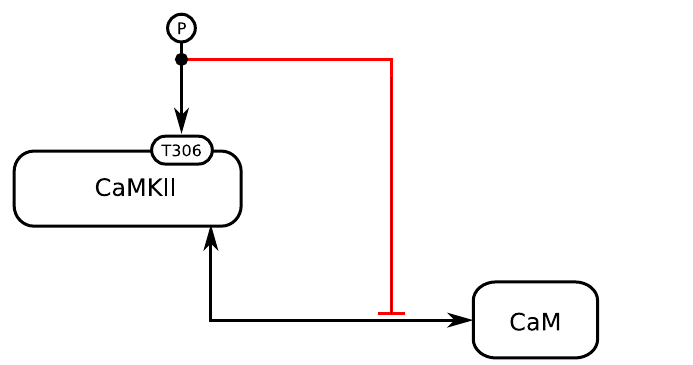
Figure 2.24: In this example, the phosphorylation of the threonine 306 of the regulatory domain of CaMKII inhibits the interaction between Calmodulin and the